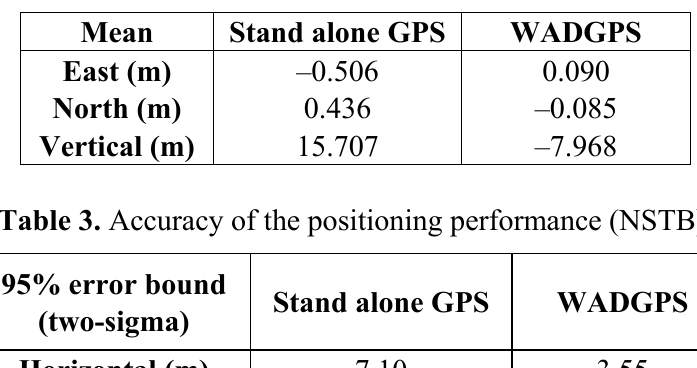
Table 2. Mean of the positioning error (NSTB).